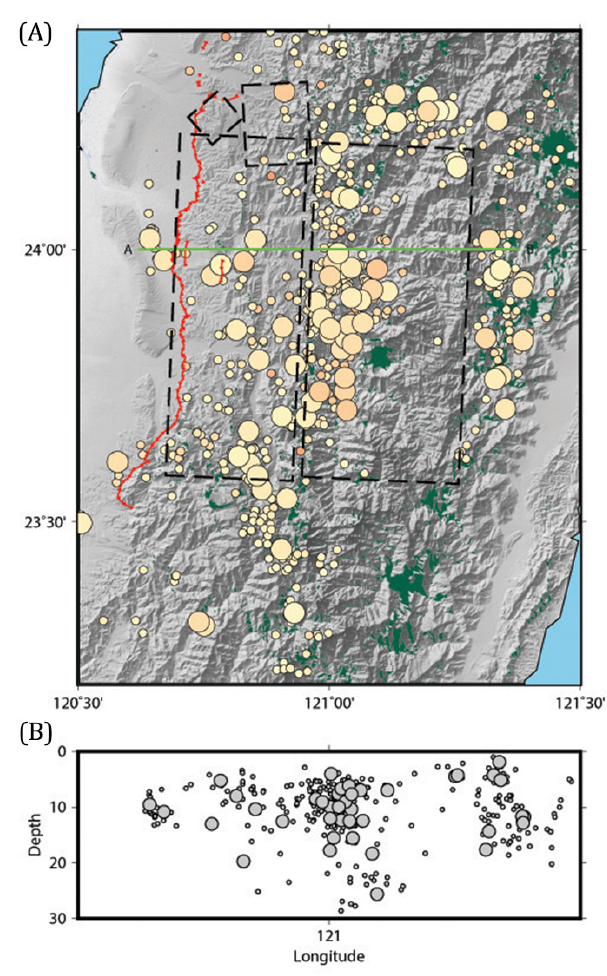
Figure 11. ( A ) Position of the chelungpu fault (in red) and the fault geometry in black. Dots are representing the aftershocks during the 6 months following the event. Larger dots: M w ≥ 5, small ones 3 ≤ M w < 5. ( B ) A-B profile showing the aftershocks in depth